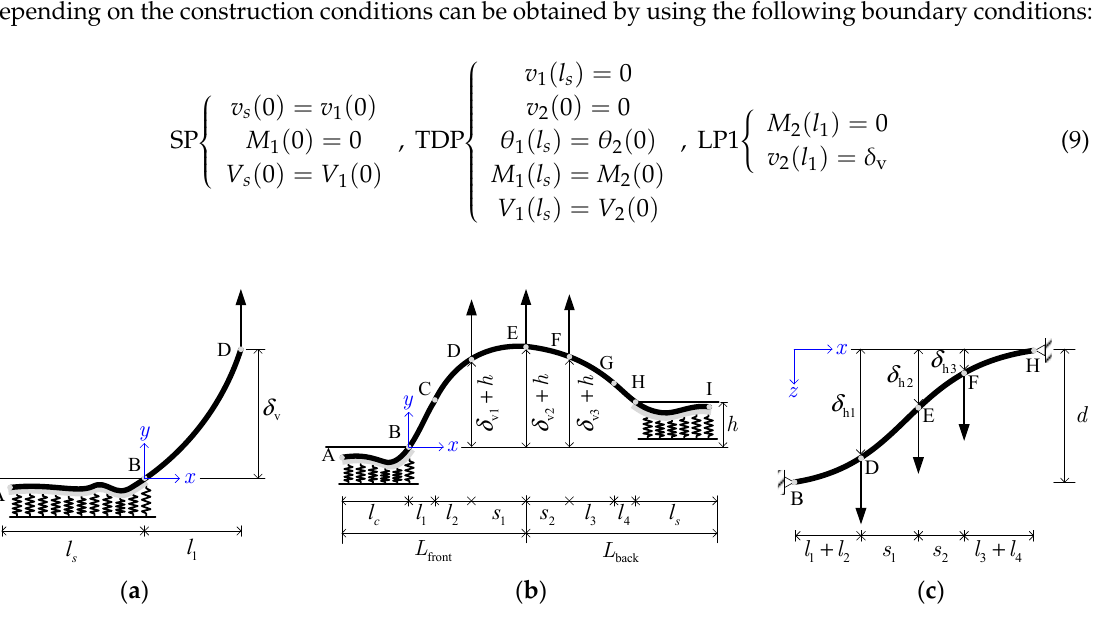
Figure 6. Segmental pipeline model during lowering-in ( a ) Model 1; ( b ) Model 2; ( c ) lateral plane of Model 2 (A:SP, B:TDP, C:IP1, D:LP1, E:LP2, F:LP3, G:IP2, H:SSP, I:EP).